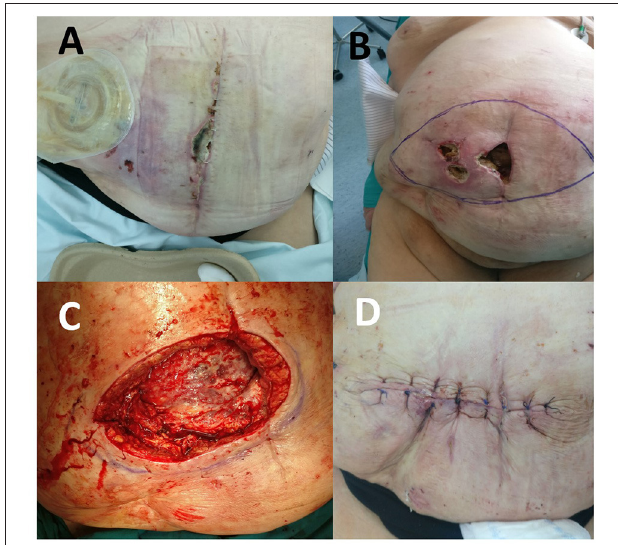
FIGURE 1 | (A) Ischemic lesion on the 8th postoperative day. (B) Two full-thickness skin necrotic foci paramedially on the 22nd postoperative day. (C) View of the abdominal wall after necrectomy on the 22nd postoperative day. (D) View of the abdominal wall after the wound was primarily closed.